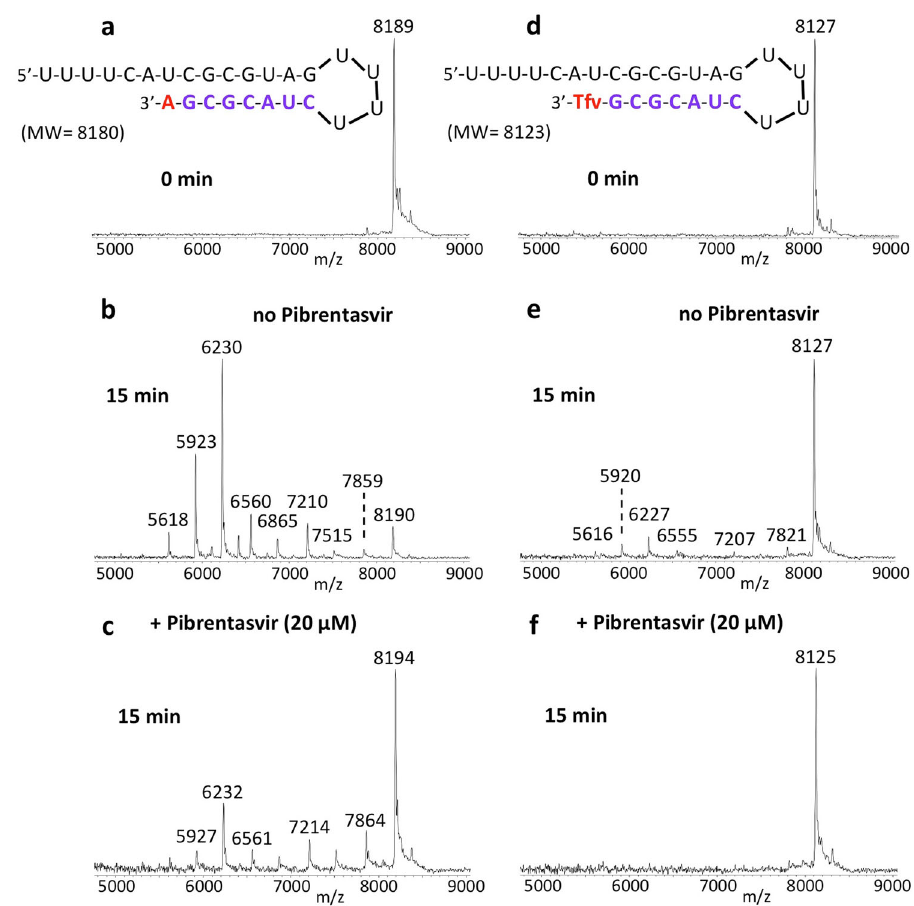
Fig. 6 Inhibition of SARS-CoV-2 exonuclease activity by Pibrentasvir for natural RNA and Tenofovir (Tfv) terminated RNA. A mixture of 500 nM RNAs (sequences shown at the top of the fi gure) and 50 nM SARS-CoV-2 pre-assembled exonuclease complex (nsp14/nsp10) were incubated in buffer solution at 37 °C for 15 min in the absence ( b , e ) and presence of 20 µ M Pibrentasvir ( c , f ). The intact RNAs ( a , d ) and the products of the exonuclease reactions ( b – f ) were analyzed by MALDI-TOF MS. The signal intensity was normalized to the highest peak. In the absence of Pibrentasvir, exonuclease activity caused nucleotide cleavage from the 3 ′ -end of the natural RNA as shown by the lower molecular weight fragments corresponding to cleavage of 1 – 8 nucleotides ( b ). However, for Tfv-terminated RNA, only minor cleavage was observed ( e ). When 20 µ M Pibrentasvir was added, exonuclease activity was reduced as shown by the reduced intensities of the fragmentation peaks and the increased peak height of the intact RNA ( c , f